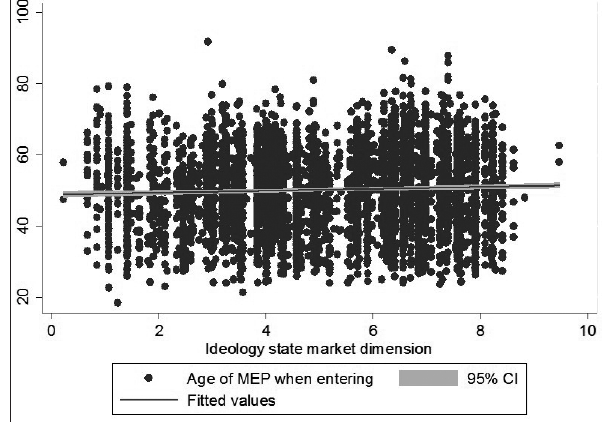
Figure 1: Scatterplot displaying the relationship between the age of the party leader and the age of MEPs from this party